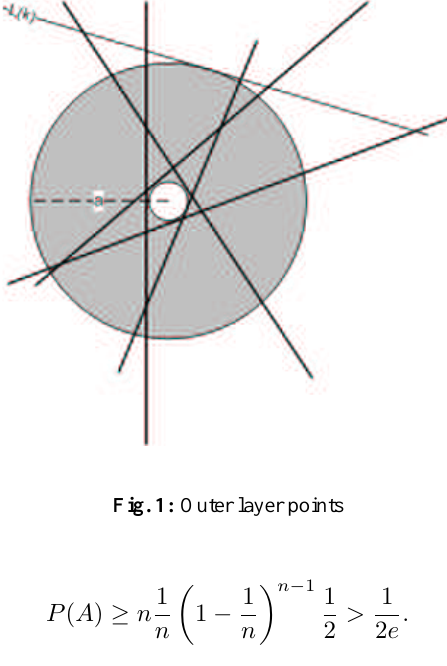
Fig. 1: Outer layer